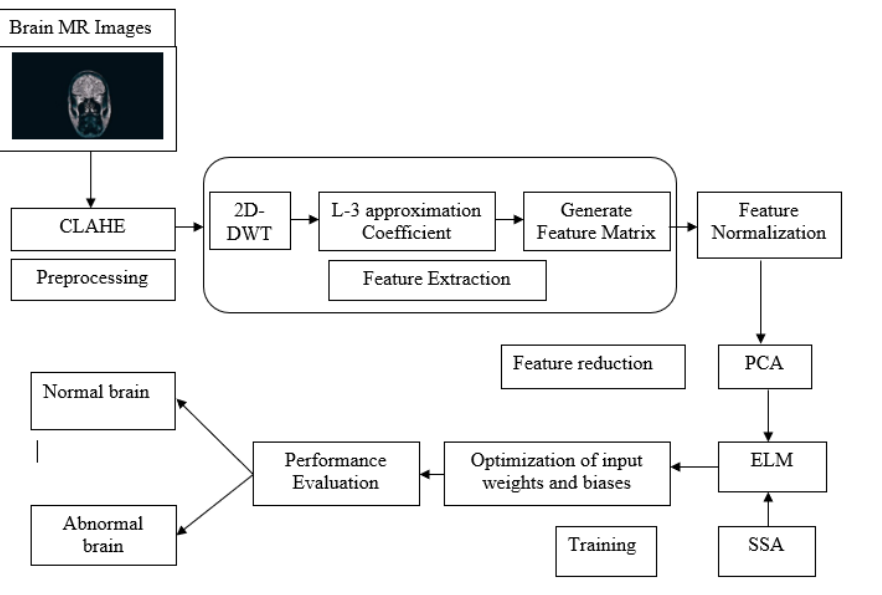
Figure 4. Model for propose ELM-SSA classification of MR brain images.